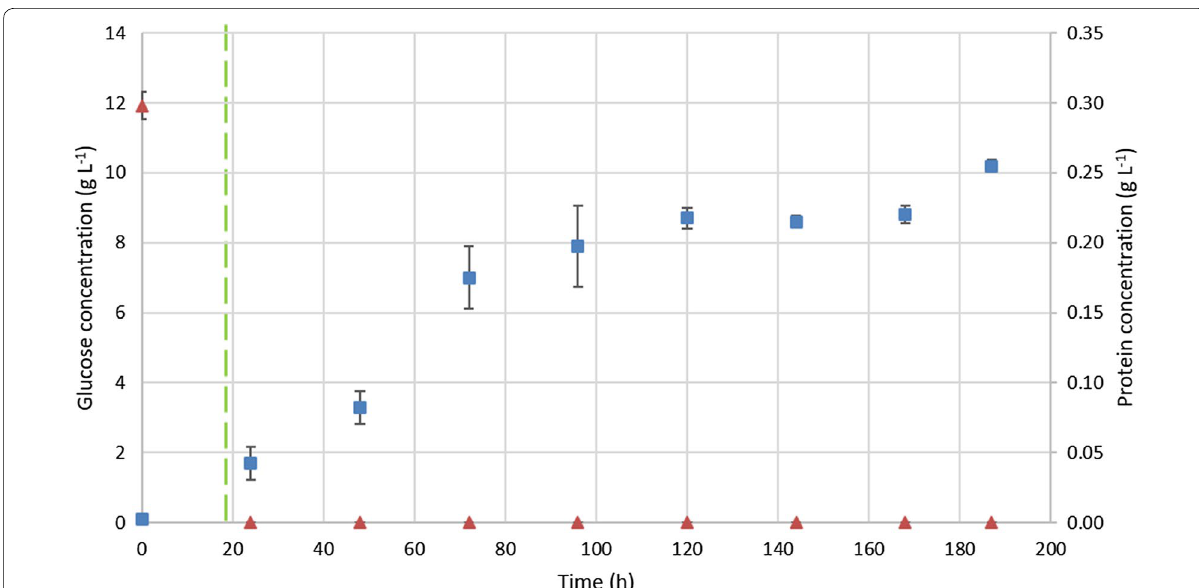
Fig. 2 Glucose and protein content analysis of the bioreactor cultivation. Glucose (orange traingle) and protein (blue sqaure) concentration over time during the Trichoderma harzianum cultivation. After 19 h the fed-batch phase was initiated using Schwanniomyces occidentalis as feed (green dashed line). The glucose concentration remained at 0 g L − 1 from this time on, while the protein content increased towards 0.26 g L − 1 . After 187 h the cultivation was stopped and the supernatant containing the tailor-made enzymes (TMEs) was harvested